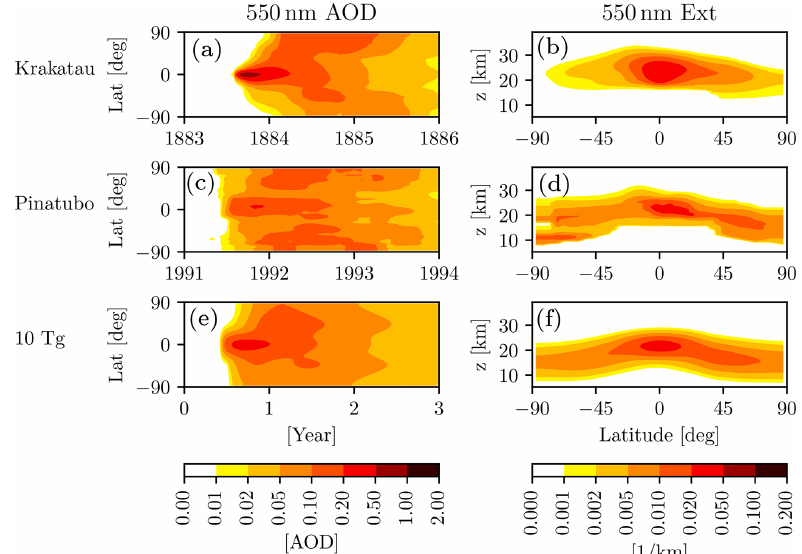
Figure A1. As in Fig. 1, but for the CMIP6 volcanic aerosol prescription (Miller et al., 2021), for Pinatubo (a, b) and Krakatau (c, d) . For comparison, the EVA 10Tg(S) aerosols are shown in (e) and (f) .